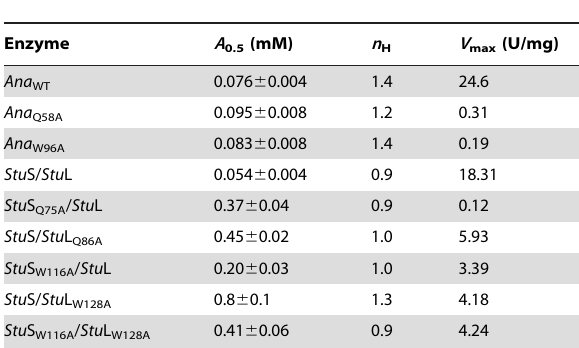
Table 1. Kinetic parameters obtained for 3-PGA with the Anabaena and potato tuber ADP-Glc PPases and their mutants.